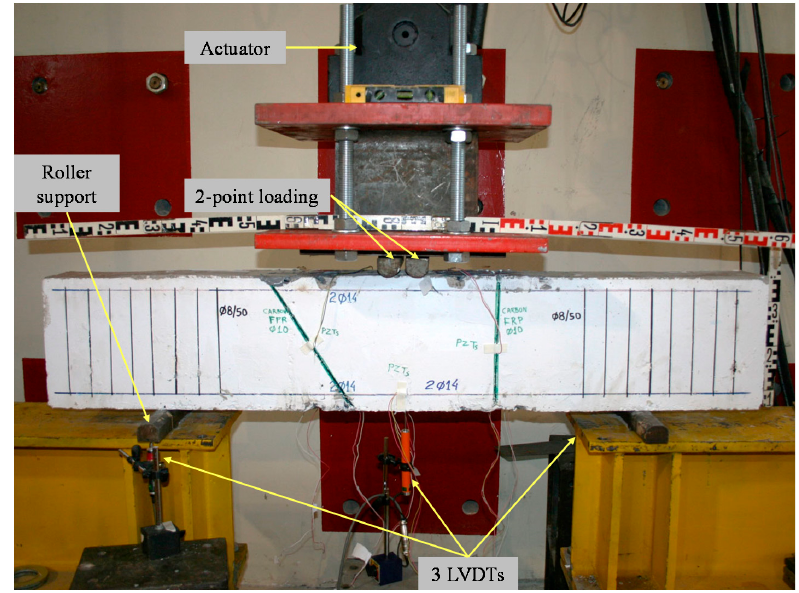
Figure 6. Test rig and instrumentation.